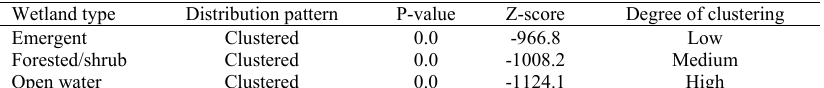
Table 4: Distribution pattern of inland wetland types in middle Tennessee